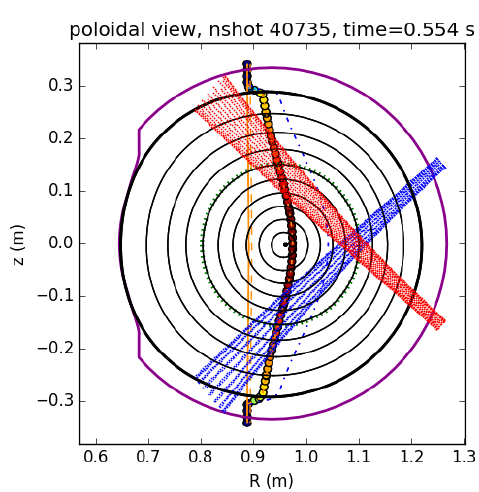
Fig. 15. Plasma reconstructed equilibrium and resonances for shot #40735 with symmetric launch: receiving beam crosses the probe beam close to the q=3 rational surface (dotted circle in green) where a MHD island exists. Before reaching the EC resonance (thin vertical line) the beams intersect again the q=3 surface, in the proximity of the UH resonance (dots in